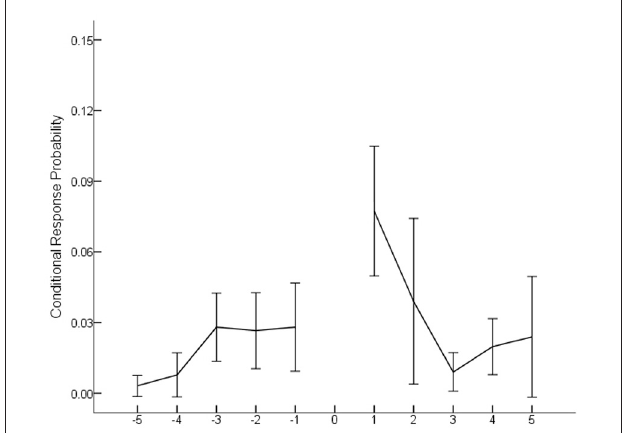
FIGURE 1 | Mean conditional probability plotted against distance from last item